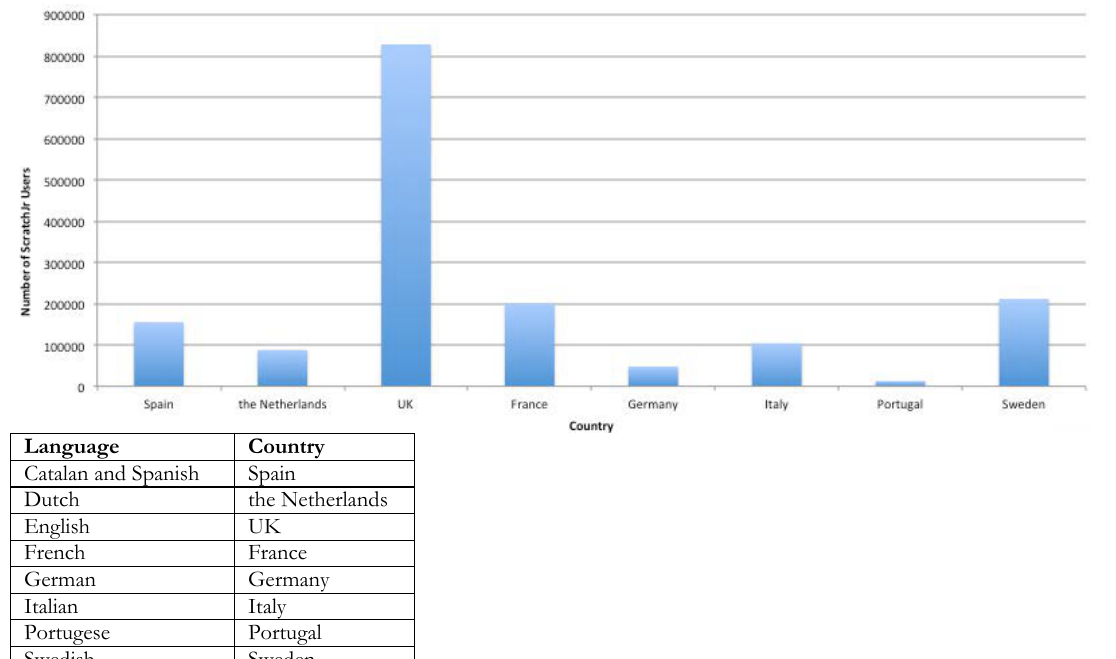
Figure 11. The number of ScratchJr users in European countries with languages included in ScratchJr